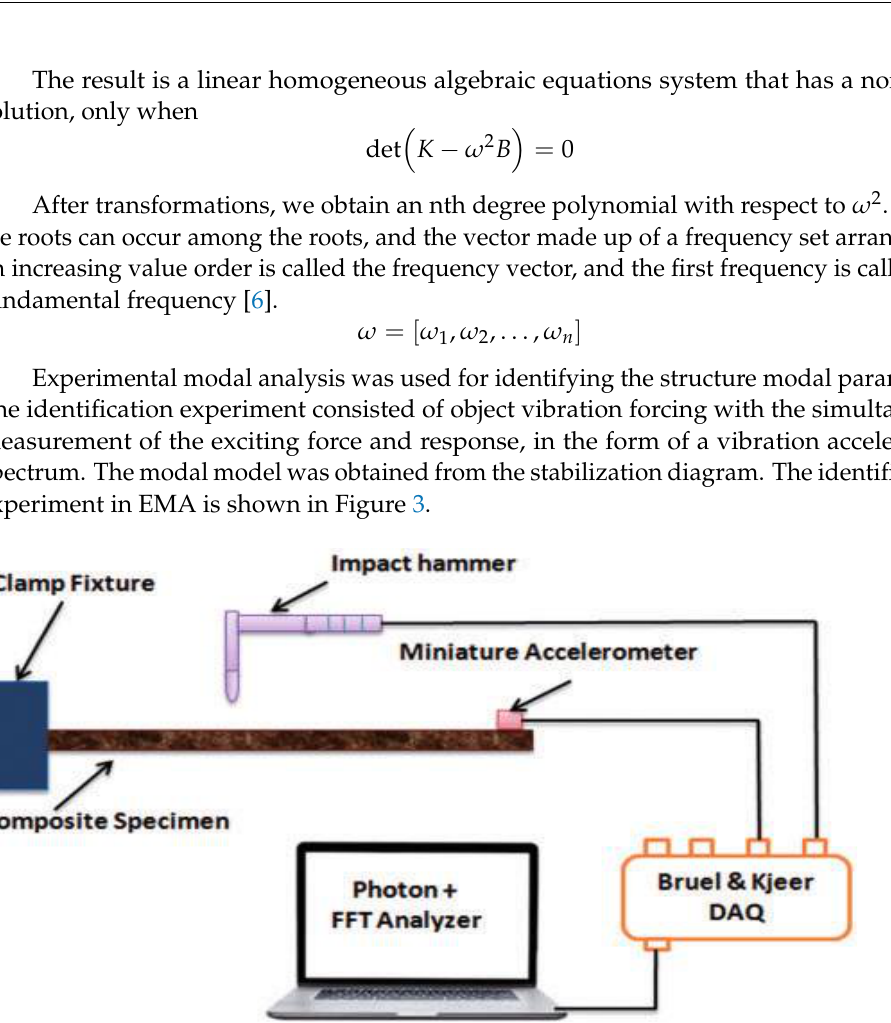
Figure 3. The essence of research in experimental and operational modal